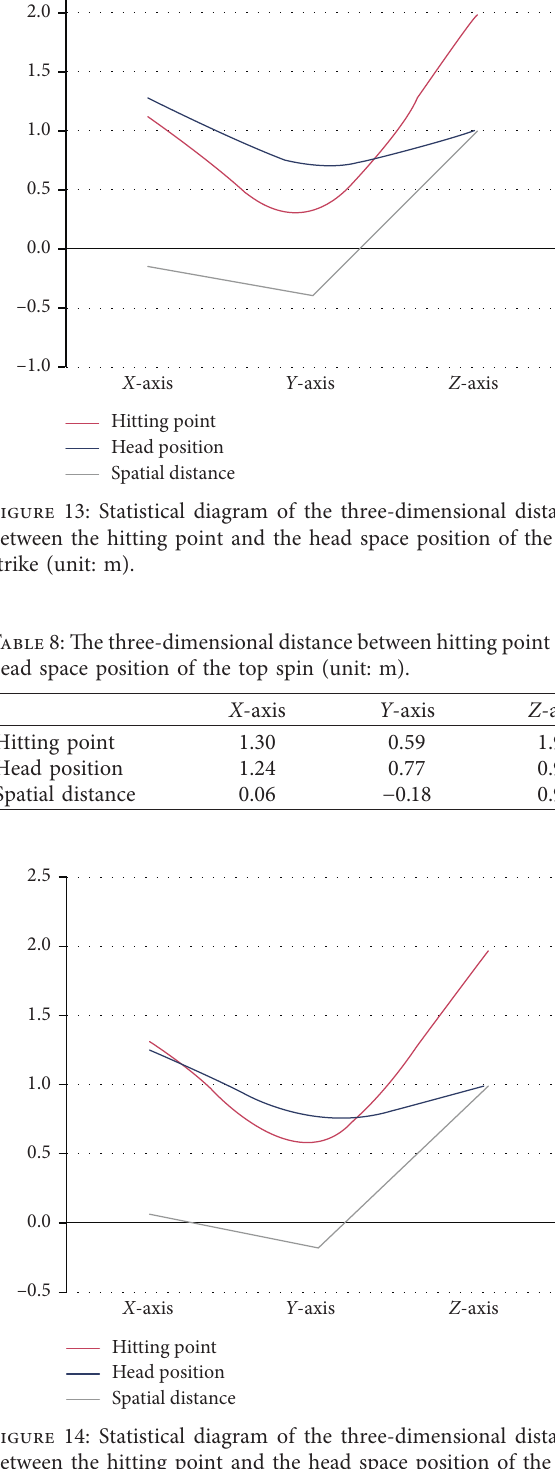
Table 9: Statistical table of the angle between the racket and the ground at the moment of hitting the ball (unit: ° ).